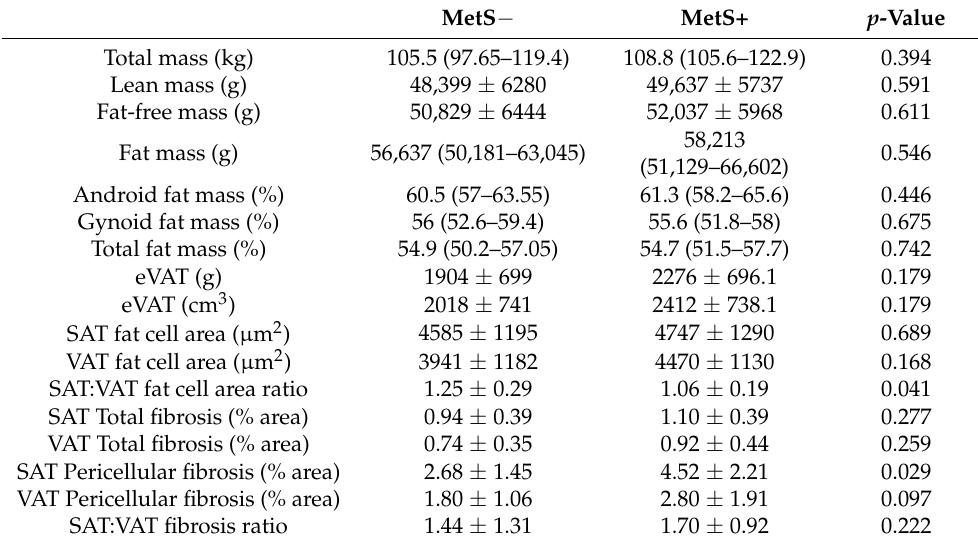
Table 2. Body composition characteristics and adipose tissue histological